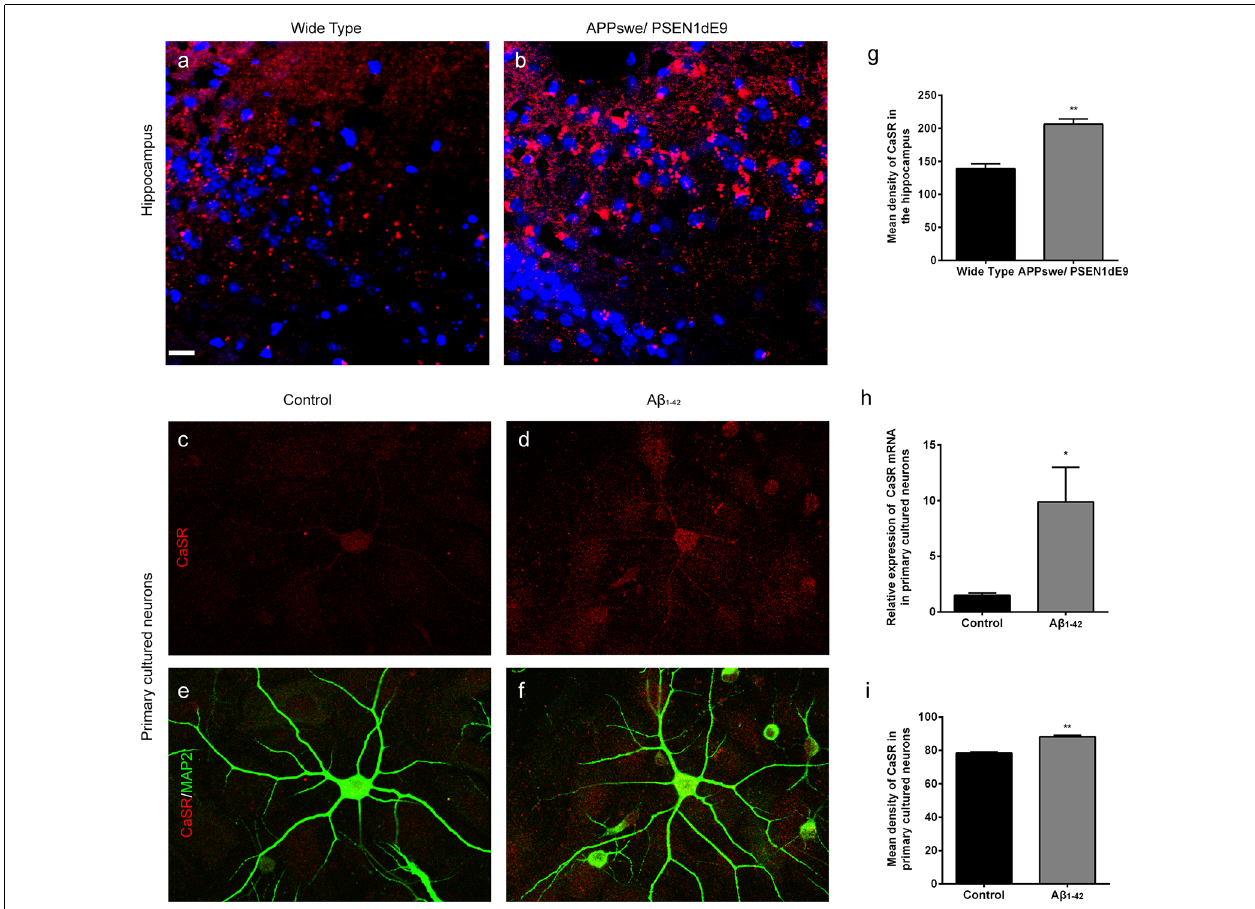
FIGURE 1 | The expression levels of calcium-sensing receptor (CaSR) were increased in Alzheimer’s disease (AD) mice and β -amyloid peptide (A β 1–42 )-treated primary hippocampal neurons. (A,B) Immunostaining of CaSR (red) and DAPI (blue) in the hippocampus of wild type and APPswe/PSEN1dE9 transgenic mice. Scale bar 20 µ m. (C–F) Immunostaining of CaSR (red) and neuronal marker MAP2 (green) in primary cultured neurons in the control and 0.5 µ M A β 1–42 -treated group. (G) Quantitative comparison of the mean density of CaSR in the hippocampus of wild type and APPswe/PSEN1dE9 transgenic mice. ** P < 0.01 vs. wild type group. Values represent mean ± SEM, n = 6 animals for each group. (H) Quantitative comparison of the mRNA levels of CaSR in control and A β 1–42 -treated neurons. * P < 0.05 vs. control group. n = 9 repeats from three independent primary cell culture preparations. (I) Quantitative comparison of the mean density of CaSR in control and A β 1–42 -treated neurons. ** P < 0.01 vs. control group, n = 48–51 neurons from three independent primary cell culture preparations.